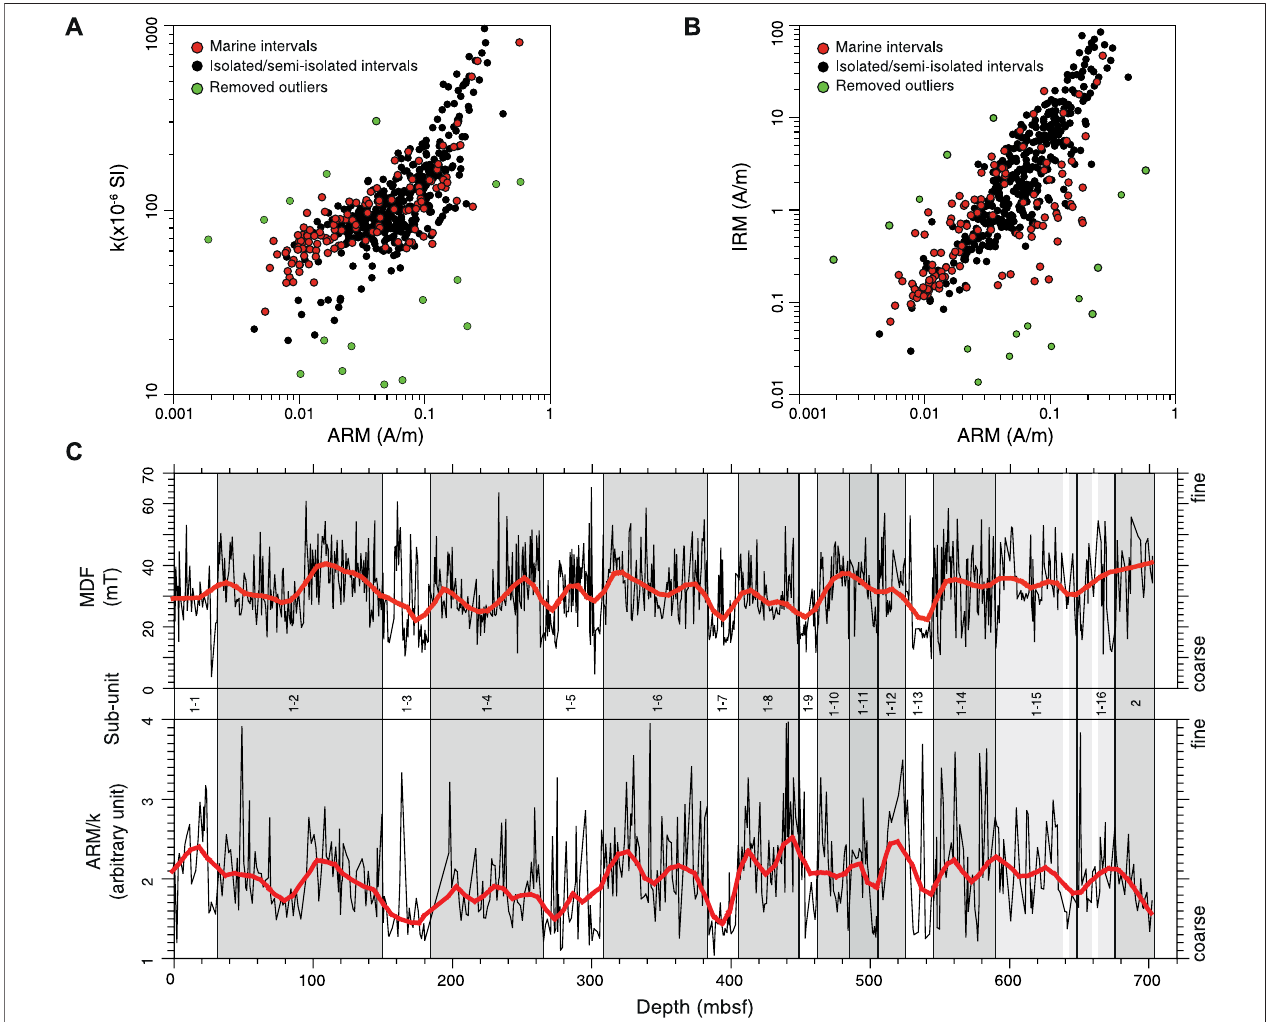
FIGURE 3 | (A) Anhysteretic remanent magnetization (ARM) versus magnetic susceptibility (k); (B) ARM versus isothermal remanent magnetization (IRM); (C) downholevariationofthemedium destructive fi eld(MDF)(upperplot) andARM/kratio(lowerplot). High(low) peakscorrespondto fi ne(coarse)magneticgrains. Original MDFandARM/kdatapointsconnectedbylinesinbothplotsareinterpolatedbyaweightedaveragewith5%smoothingfactor(thicklines).Whiteandgrayshadedareas correspond to marine/interglacial and isolated/glacial intervals, respectively. Light gray shaded area for subunit 1 – 15 and 1 – 16 indicate indeterminate